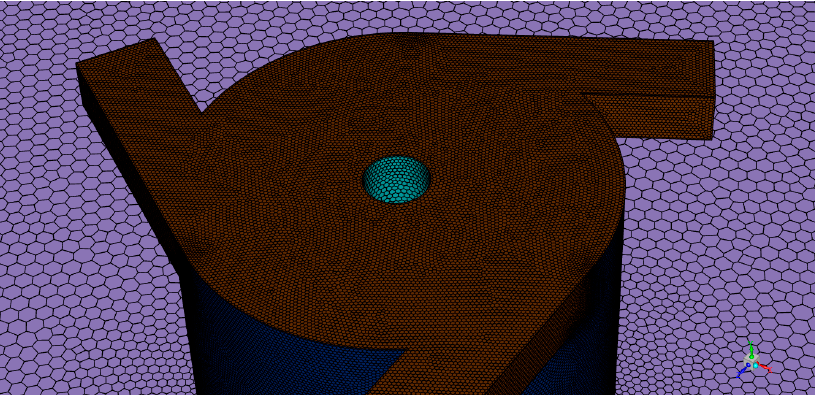
Figure 3. Surface mesh.